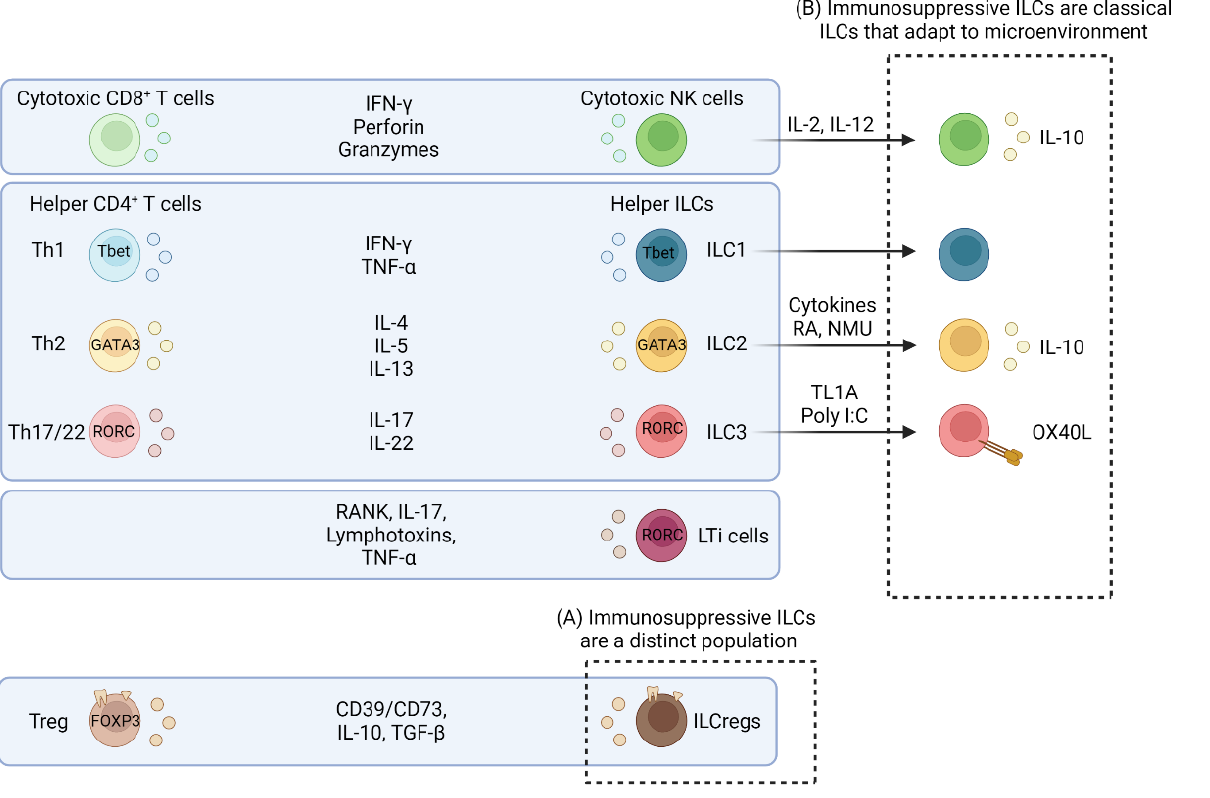
Figure 1. ILCs, including ILCregs, are classified based on functional similarities to T cell counterparts. The conventional members of ILCs (i.e., NK cells, ILC1s, ILC2s, ILC3s) were categorized based on their similarities in expression of transcription factors and cytokines to T cells (i.e., CD8 + T cells, Th1, Th2, and Th17 CD4 + helper T cells). Based on our current understanding, immunosuppressive ILCs could be added to the current classification as ( A ) a distinct population of cells (i.e., ILCregs) that share immunosuppressive features with Tregs or ( B ) as an extension of conventional ILCs that adopt suppressive features (e.g., IL-10, OX40L) following stimulation with the appropriate microenvironmental signals.